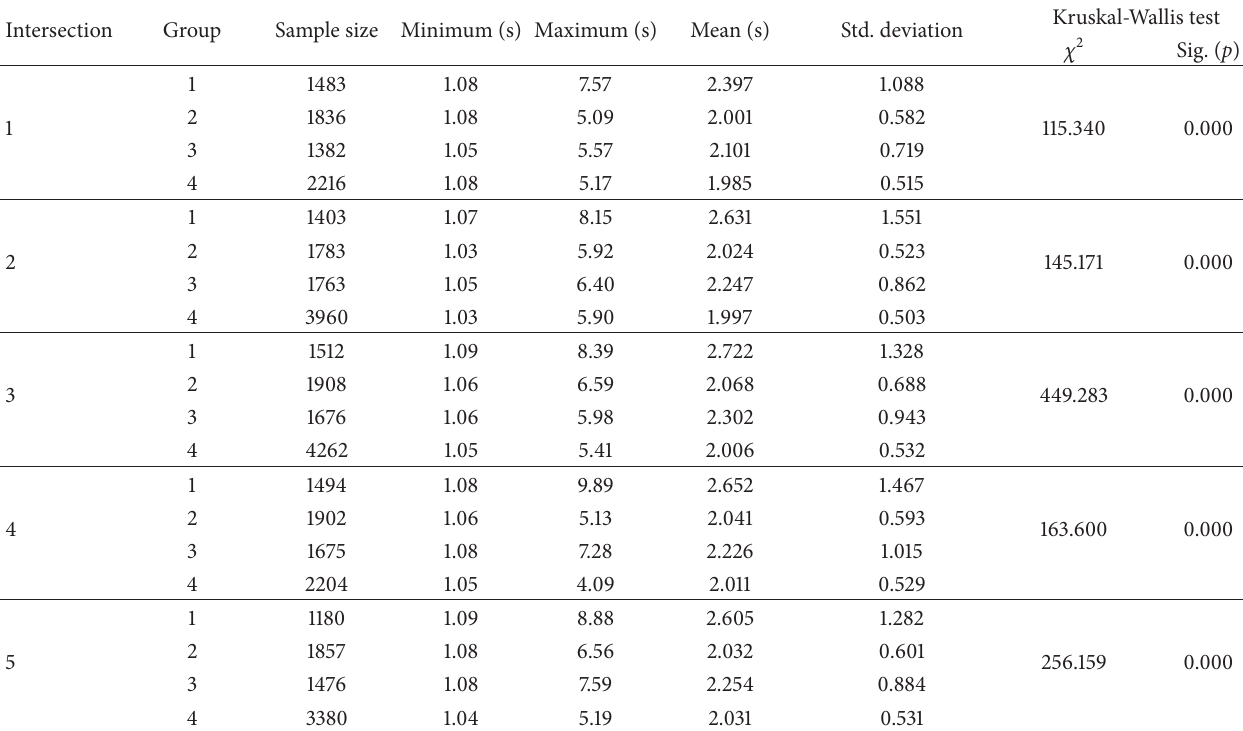
Table 3: Statistical description of the headway and nonparametric tests for several independent